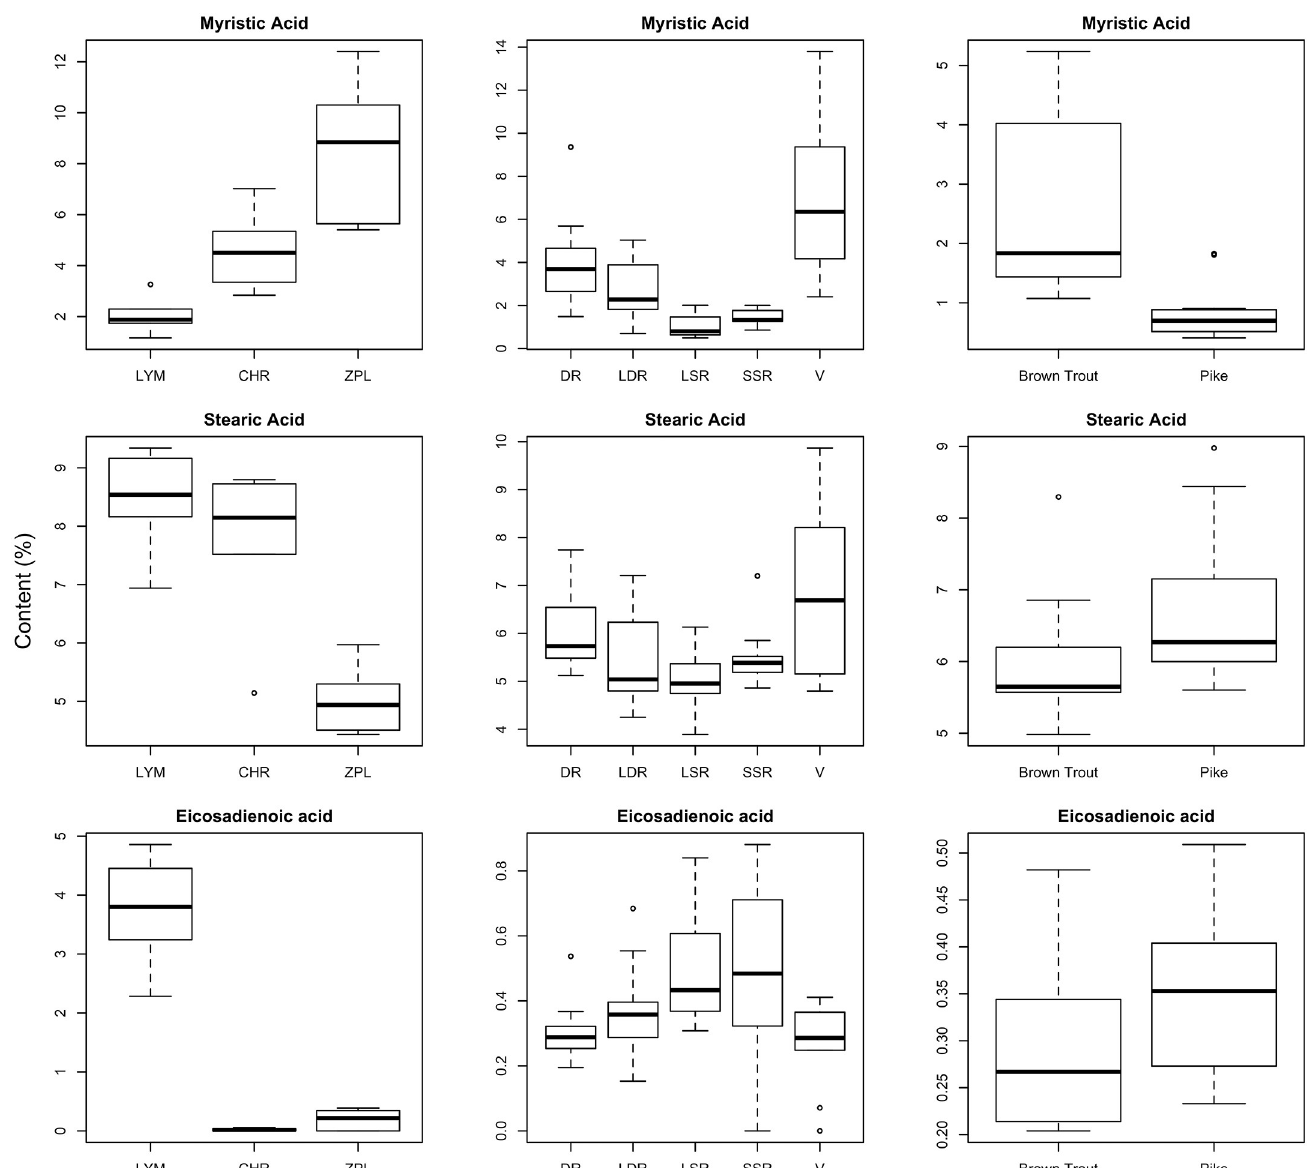
Fig 3. Boxplots of percentage concentrations of the three major fatty acids segregrating coregonid taxa across all three sampled trophic levels. LYM = Lymnaea sp., CHR = profundal chironomids, ZPL = zooplankton, DR = densely-rakered whitefish, LDR = large densely-rakered whitefish, LSR = large sparsely- rakered whitefish, SSR = small sparsely-rakered whitefish, V = vendace. https://doi.org/10.1371/journal.pone.0221338.g003 (Fig 3), and levels varied significantly across groups (F = 19.67; p < 0.001; S6 Table); ven- 4,64 dace had significantly higher levels than all whitefish morphs (p < 0.01 in all cases), but intra- specific differences were also apparent within the whitefish morphs, with DR whitefish having higher levels than LSR and SSR whitefish (p < 0.01 in both cases), while LDR whitefish were intermediate. ANOVA (F = 6.80; p < 0.001) revealed that vendace had higher levels of stea- 4,64 ric acid than LDR, SSR and LSR (p < 0.01 in all cases), though had levels indistinguishable from DR whitefish (p = 0.225). DR had higher levels than LSR (p < 0.05). Eicosadienoic acid levels also varied across coregonid groups (F = 6.31; p < 0.001), with levels highest in 4,64